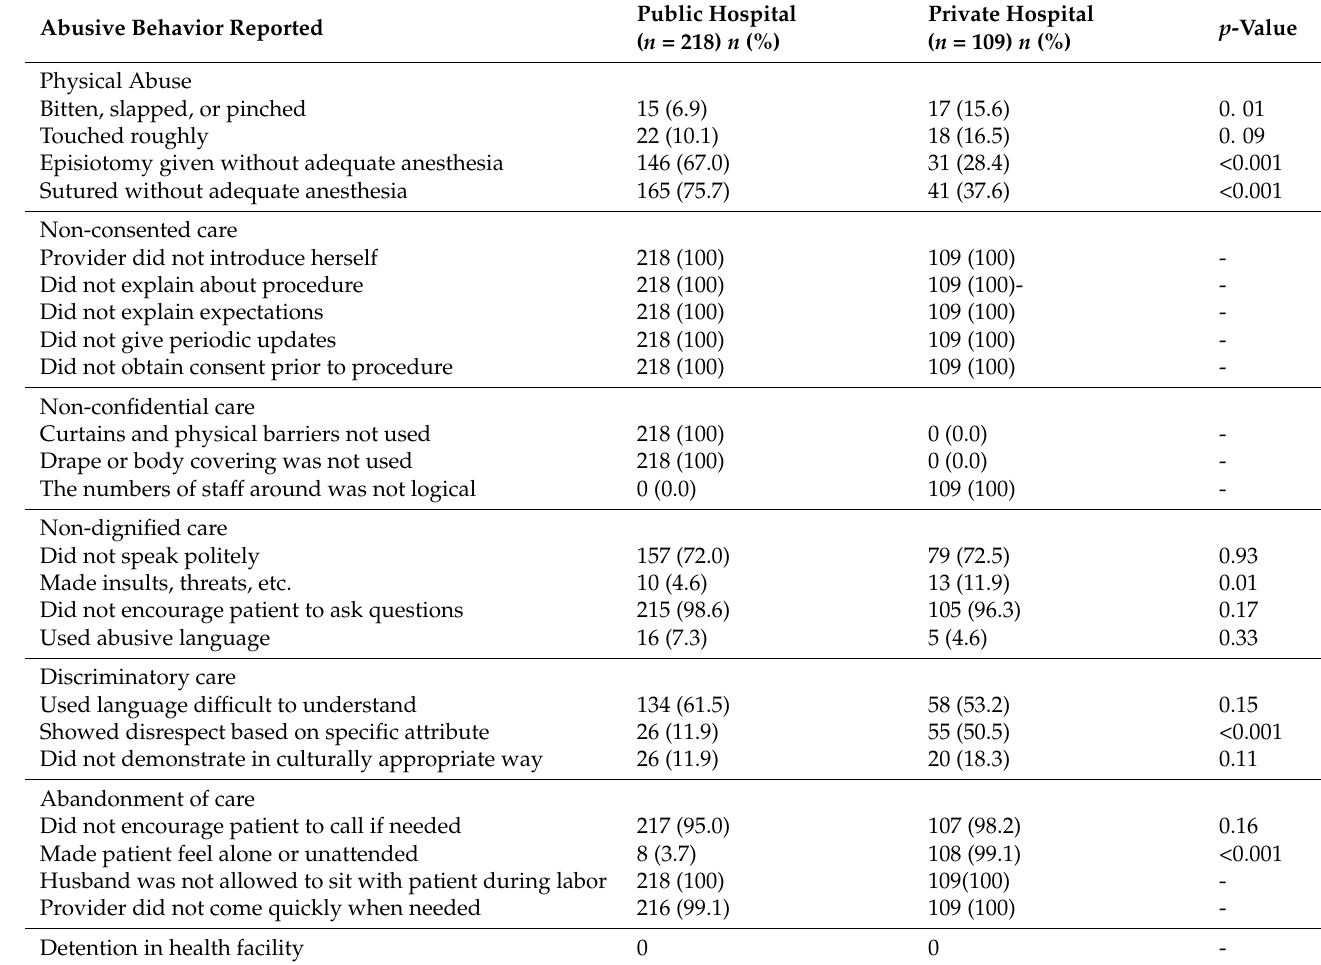
Table 3. Disrespect and Abuse during labor and delivery ( N =